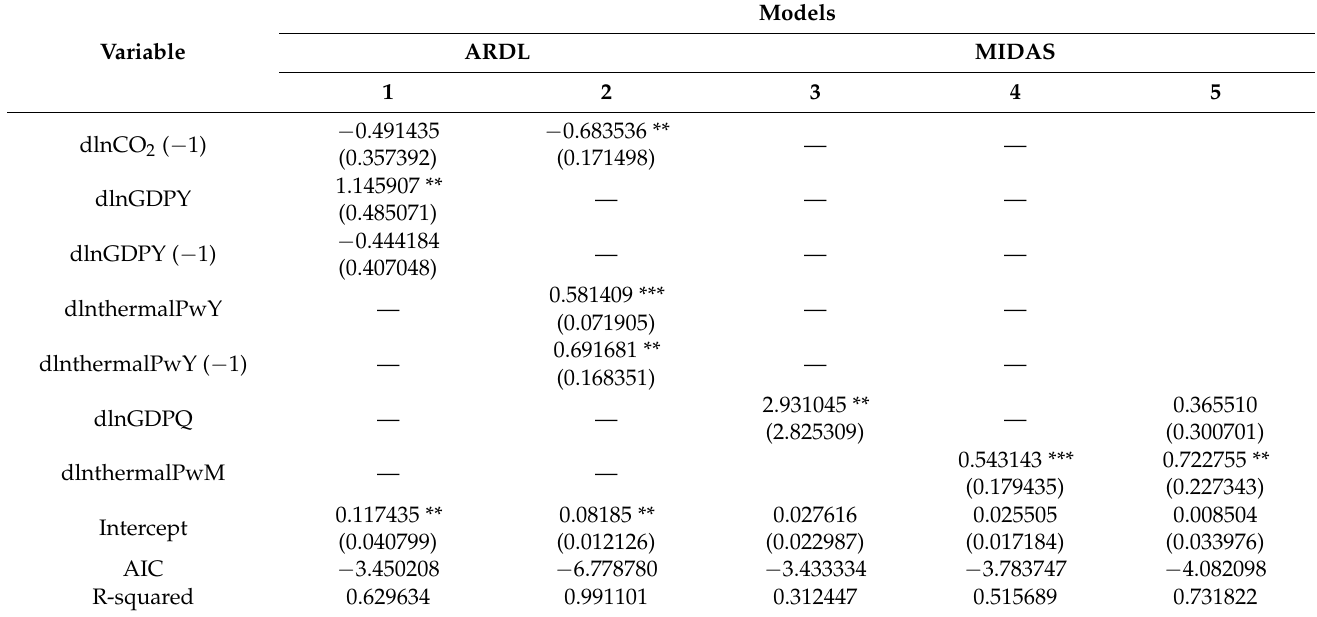
Table 5. Coefficients of the models.